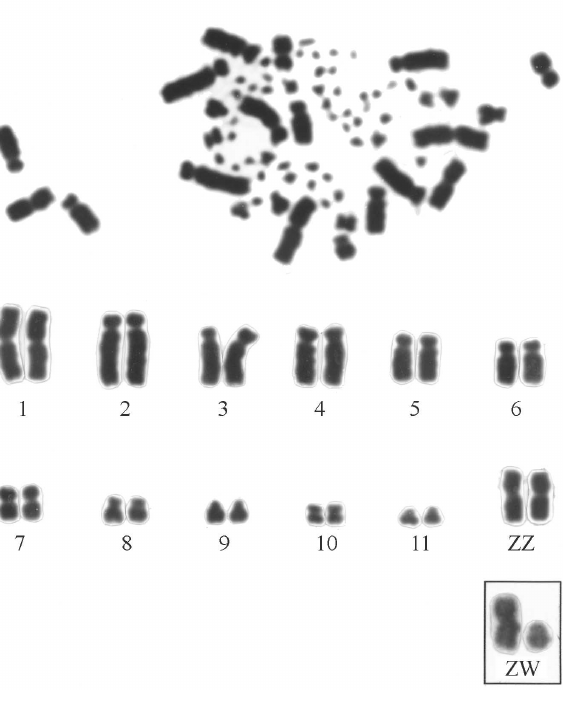
Figure 1 - Mitotic metaphase and male karyotype of Anodorhynchus hyacinthinus . In the inset, the ZW female sex chromosomes.